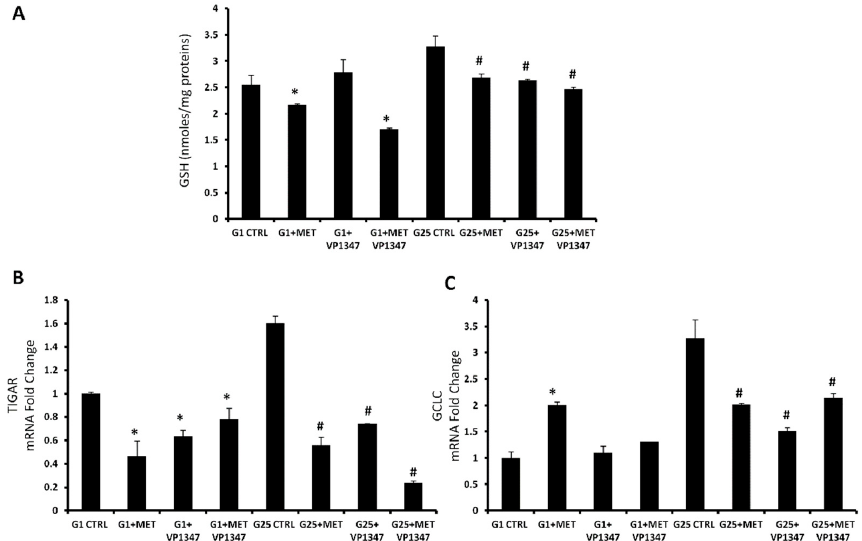
Figure 5. Metformin regulates oxidative stress pathway. ( A ) Thiol groups in DU145 cells treated for 24 h with 10 mM metformin and 10 uM VP1347. Thiol groups are expressed as nmol / mg protein. Values represent the means ± SD of three experiments performed in triplicate. * p < 0.05, significant result vs. untreated DU145 cells. ( B , C ) MRNA expression of TIGAR and GCLC of control cells with 25 mM glucose (G25), control cells with 1 mM glucose (G1), in the presence and absence of 10 mM metformin (MET) and 10 µ M VP1347 for 6 h. Results are mean ± SD, * p < 0.05 vs. G25 CTRL, # p < 0.05 vs. G1 CTRL.